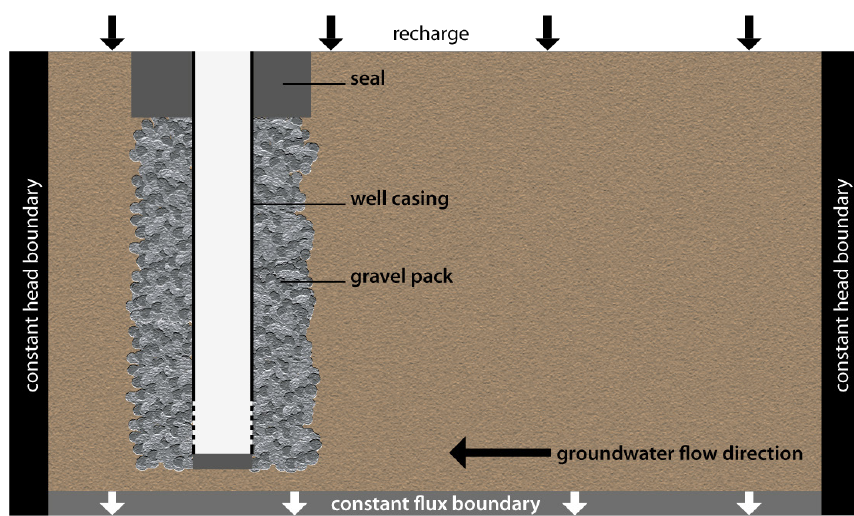
Fig. 1. Conceptual cross section of the 3-D groundwater model used to determine the size of the source area and its distance to the well (Horn and Harter, 2009). The gravel pack surrounding the well casing, the well screen, and the sealing below the surface are explicitly taken into account in the model